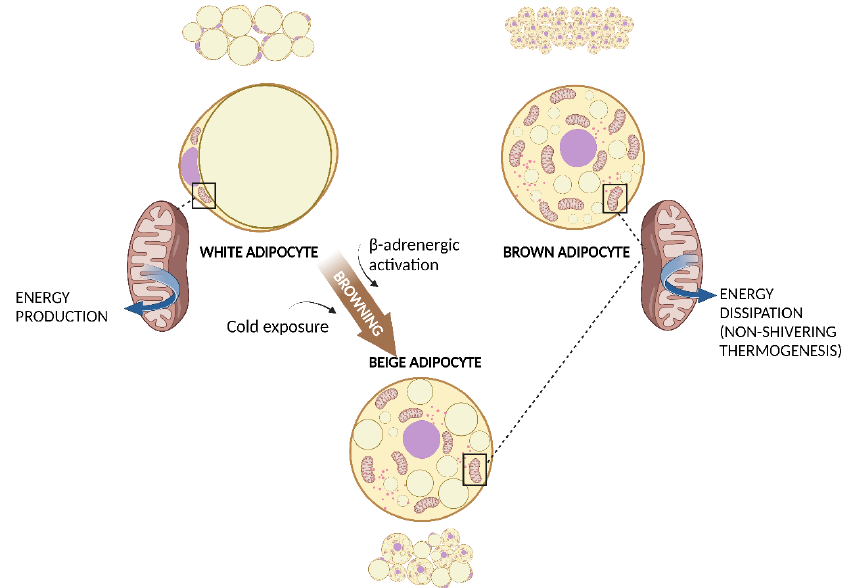
Figure 1. WAT, BAT, and WAT browning. White adipocyte has one large droplet in the centre of the cell that compresses nucleus and mitochondria at one pole. Brown adipocyte has multiple small lipid droplets and more mitochondria, spread out between the droplets. Beige adipocyte has intermediate characteristics. Cold exposure and β -adrenergic activation determine the browning of WAT. Both brown and beige mitochondria are involved in non-shivering thermogenesis. Created with BioRender.com (accessed on 13 March 2023). Abbreviations: BAT, brown adipose tissue; WAT, white adipose